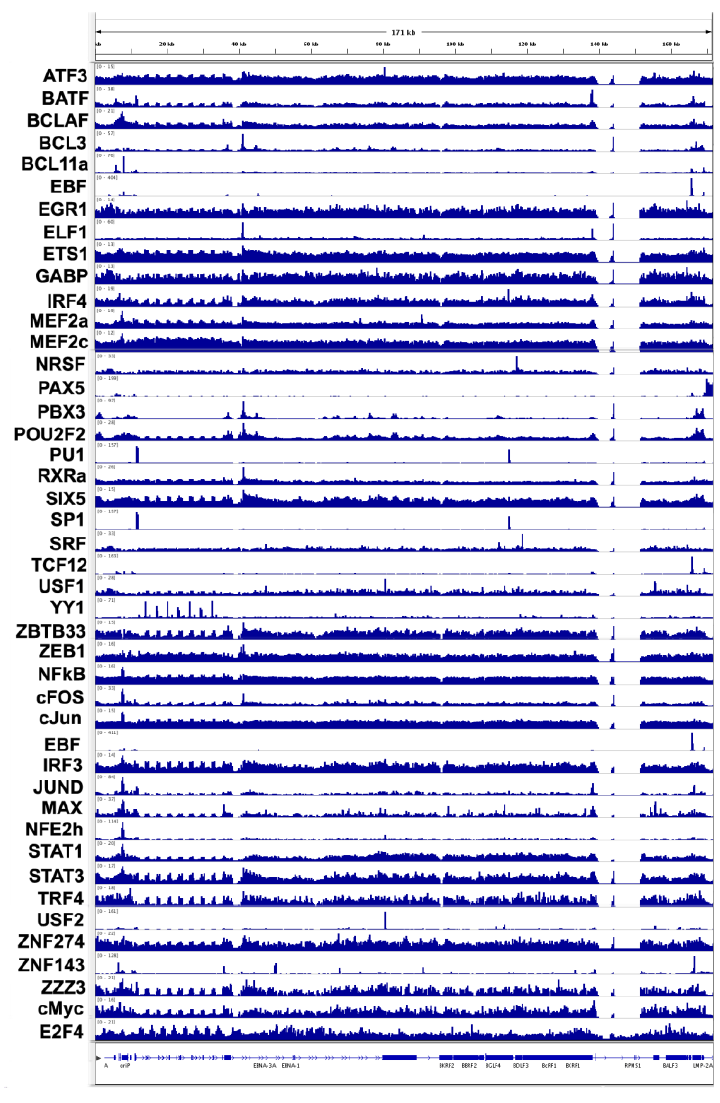
Figure 2. Transcription factor occupancy on the EBV epigenome. ChIP-seq tracks for various transcription factors (as indicated) were mapped from B95-8 LCLs. There is extensive colocalization at multiple loci across the